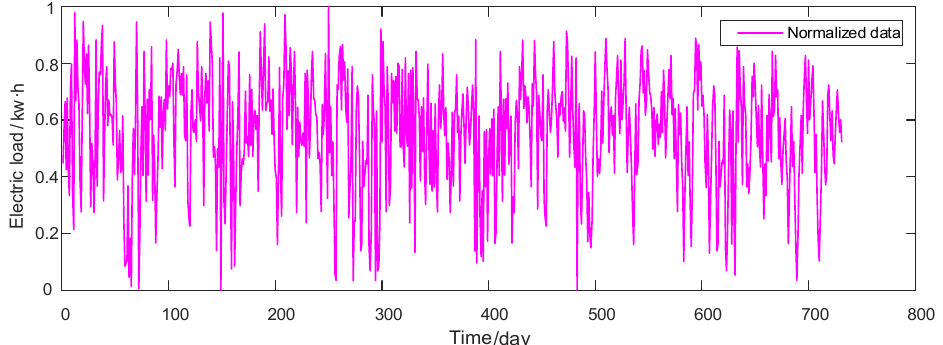
Figure 4. Original power load training data.